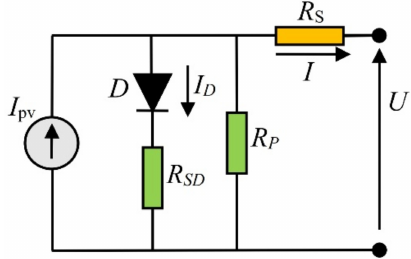
Figure 2. Improved solar PV equivalent circuit,